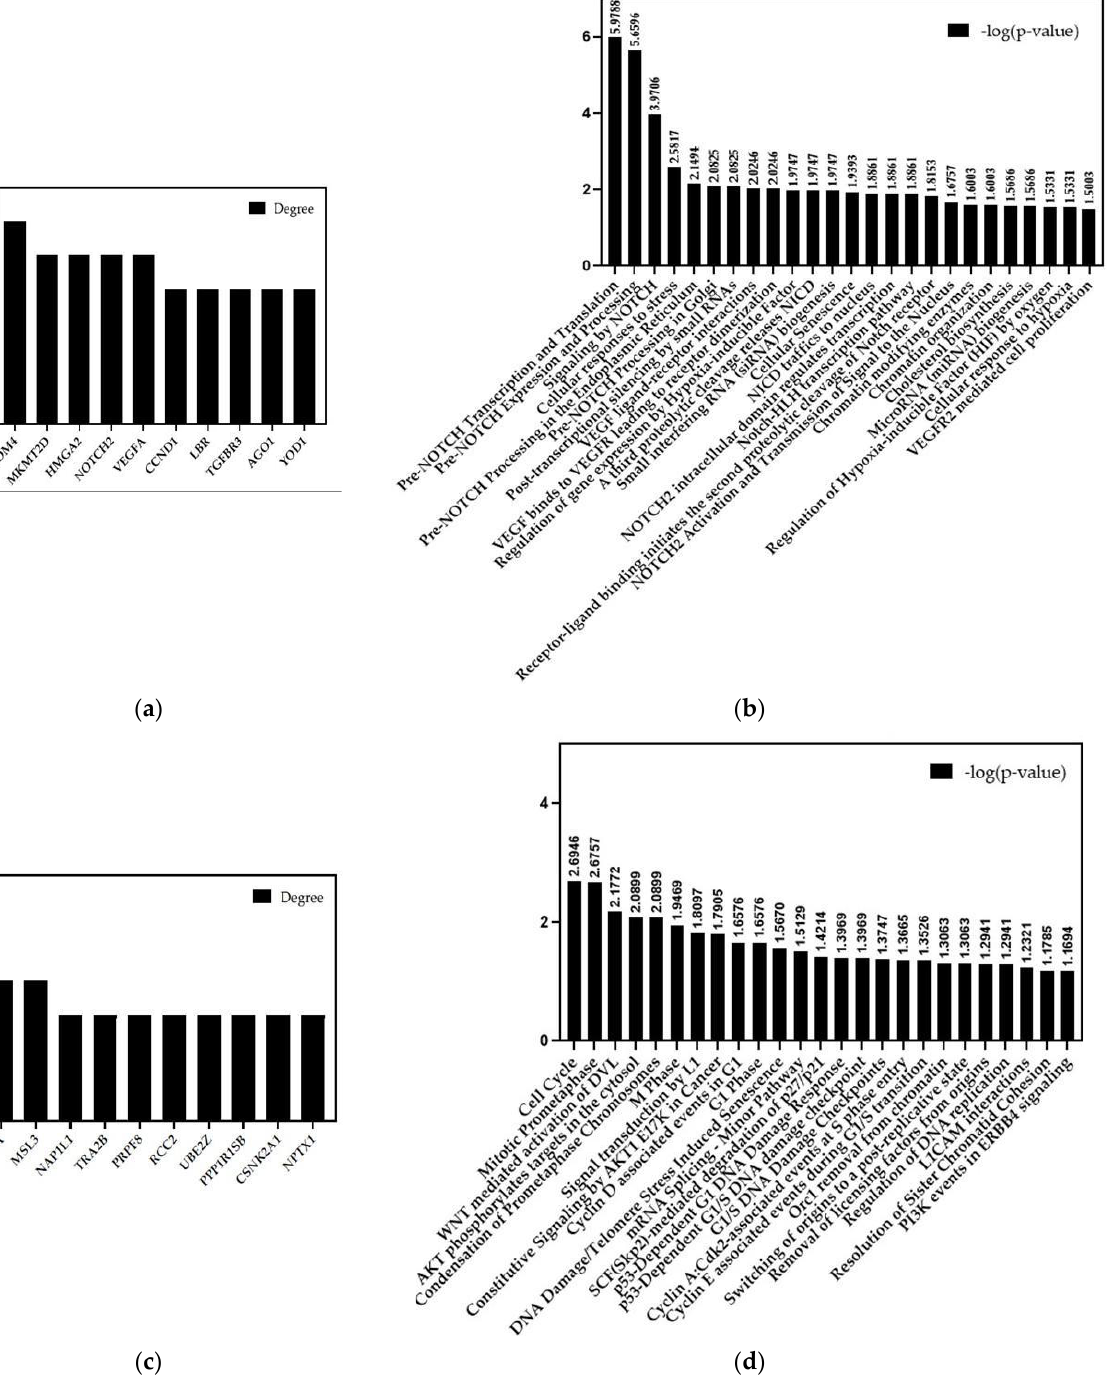
Figure 7. Functional enrichment analysis of sEV-miRNA from treated HUVECs. ( a ) The 10 main target genes regulated by the upregulated sEV-miRNAs. ( b ) Biological pathways regulated by these target genes. ( c ) The 10 main target genes regulated by the downregulated sEV-miRNAs. ( d ) Biological pathways regulated by these target genes.